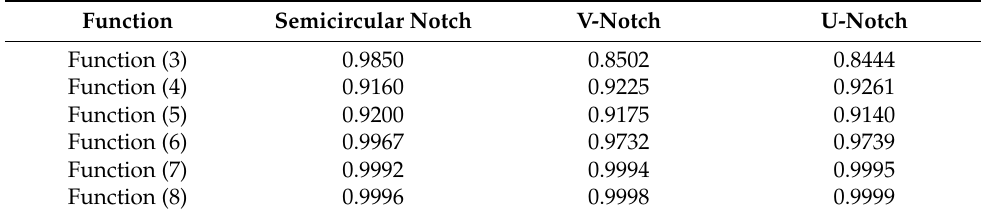
Table 1. R 2 value of different types of notches. Function Semicircular Notch